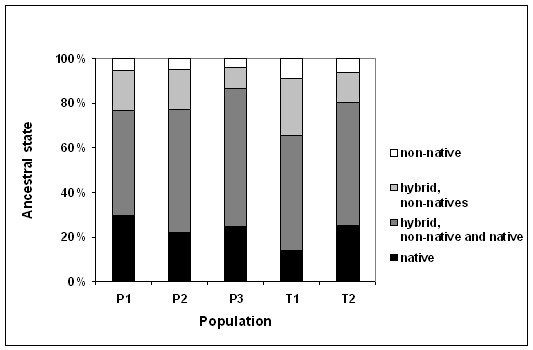
Ancestral origins. Pooled ancestral state proportions of spawning char at site P1 - 3 in Lake Pålsbufjord, and site T1 - 2 in Lake Tunhovdfjord, estimated in BIMR. Hybrid native indicates that one parent is from the local population, while hybrid non-native indicate parental origin of two different non-native populations.